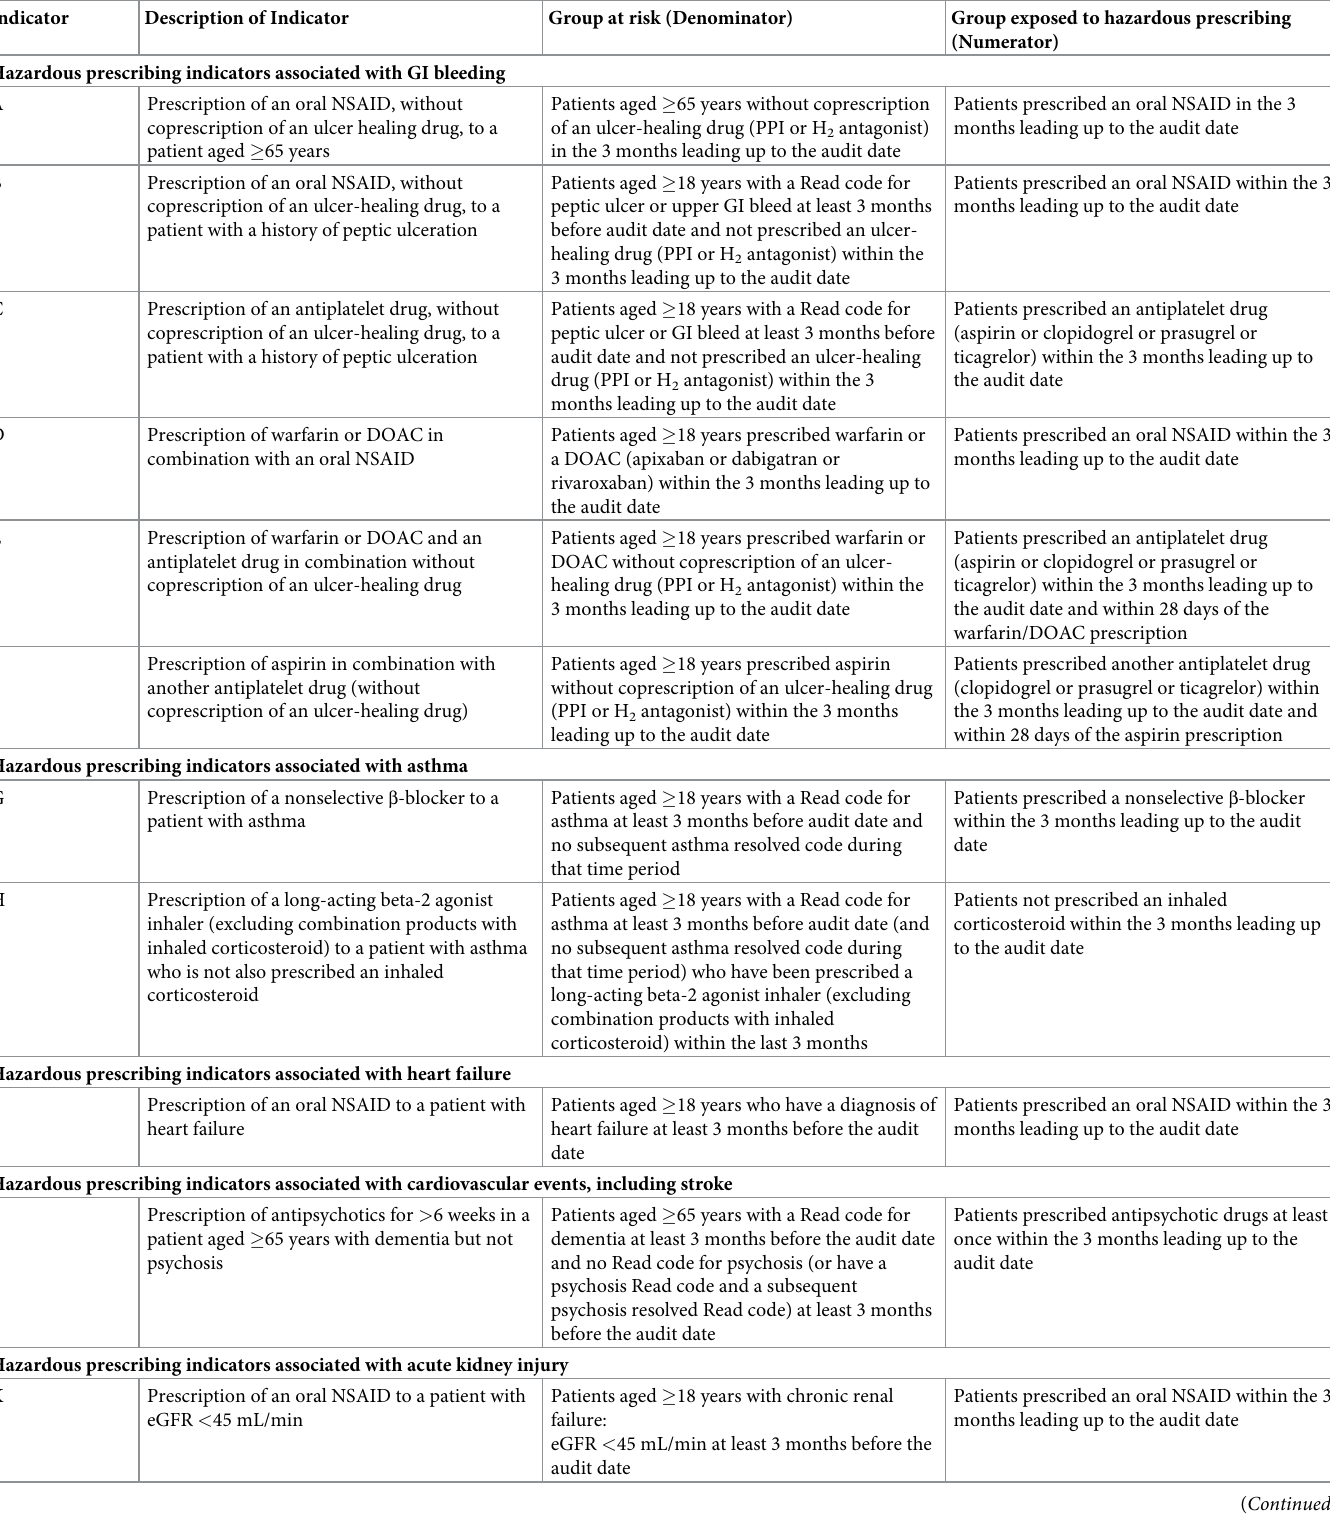
Table 1. The prescribing indicators grouped by serious harm